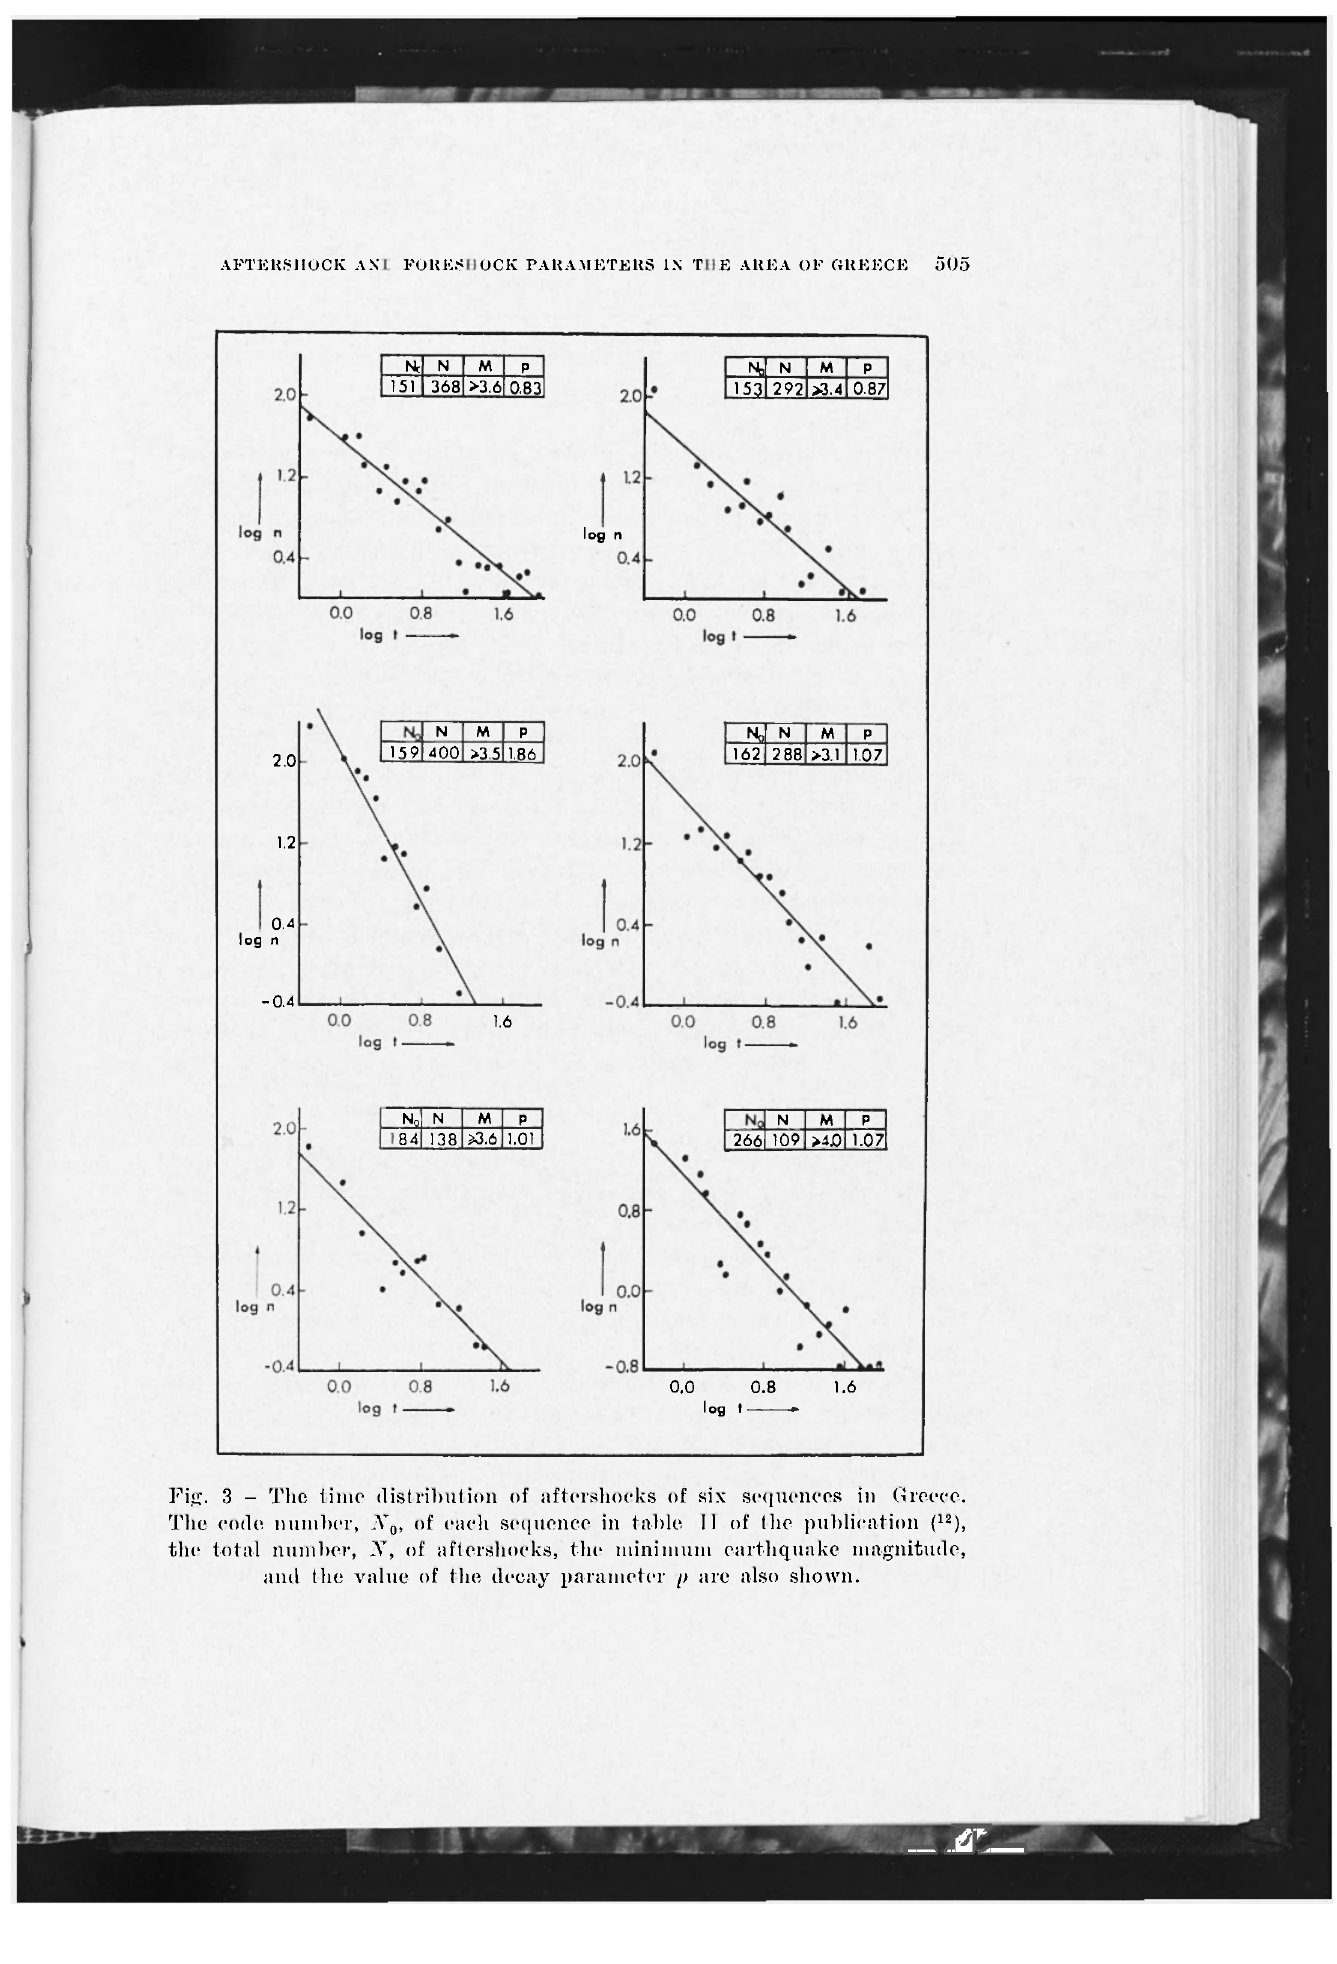
Fig. 3 - The time distribution of aftershocks of six sequences in Greece. The code number, J\ r 0 , of each sequence in table 11 of the publication ( 12 ), the total number, N, of aftershocks, the minimum earthquake magnitude, and the value of the decay parameter p are also